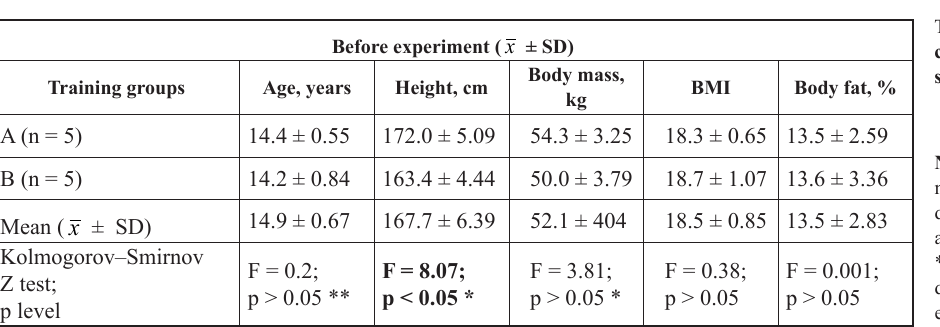
Table 1. Anthropometric characteristics of subjects ( x ±